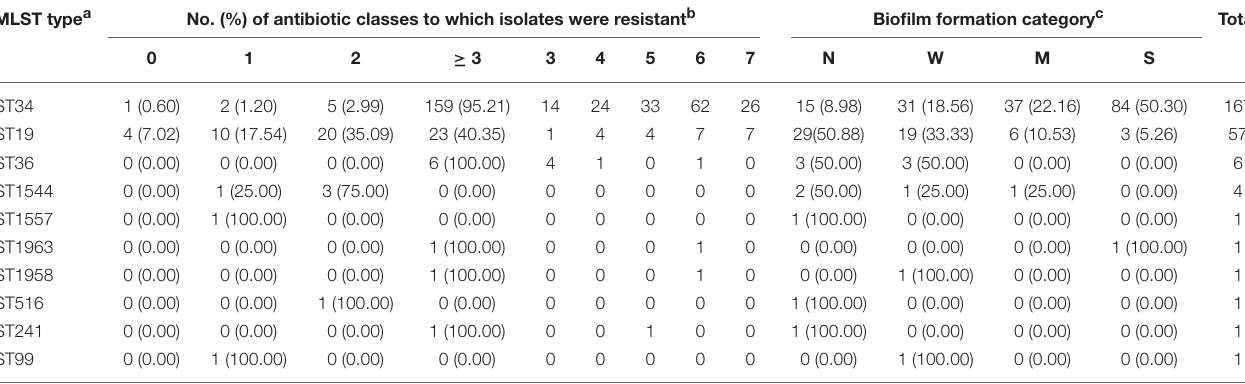
TABLE 5 | Antibiotic resistance and biofilm formation of 240 S. Typhimurium isolates of different MLST types. MLST type a No. (%) of antibiotic classes to which isolates were resistant b Biofilm formation category